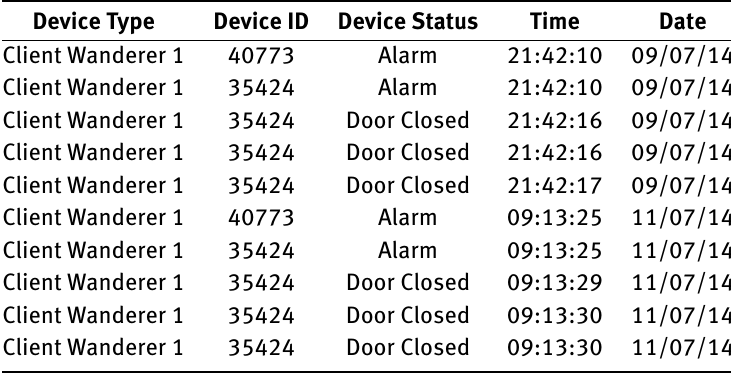
Table 1: Static Sensor Data Showing an Example of a Systemic